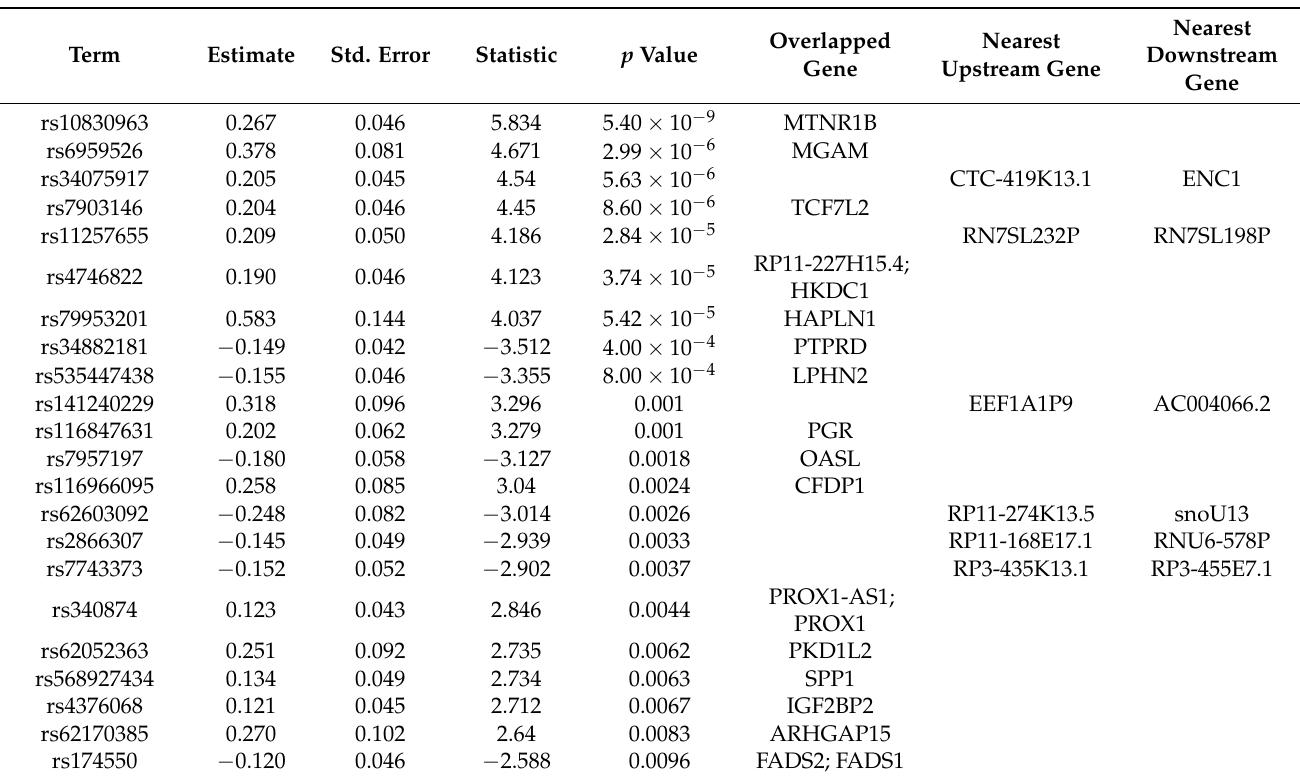
Table 1. SNPs and Weights in the Polygenic Risk Score Model Table 1 .